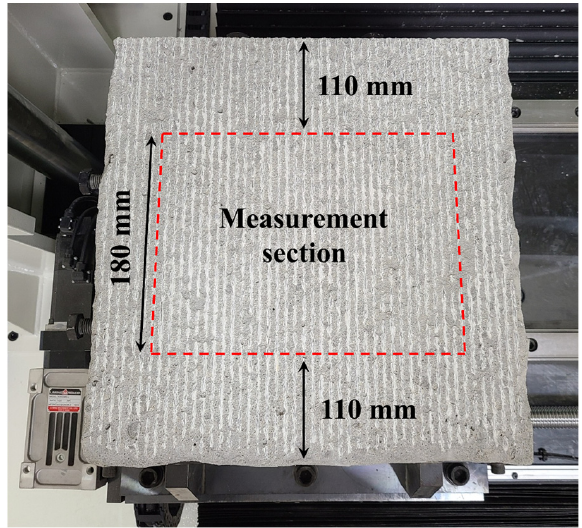
Figure 4. Preconditioning of model rock and measurement section. Table 2. Penetration depth and spacing used in cutting tests.